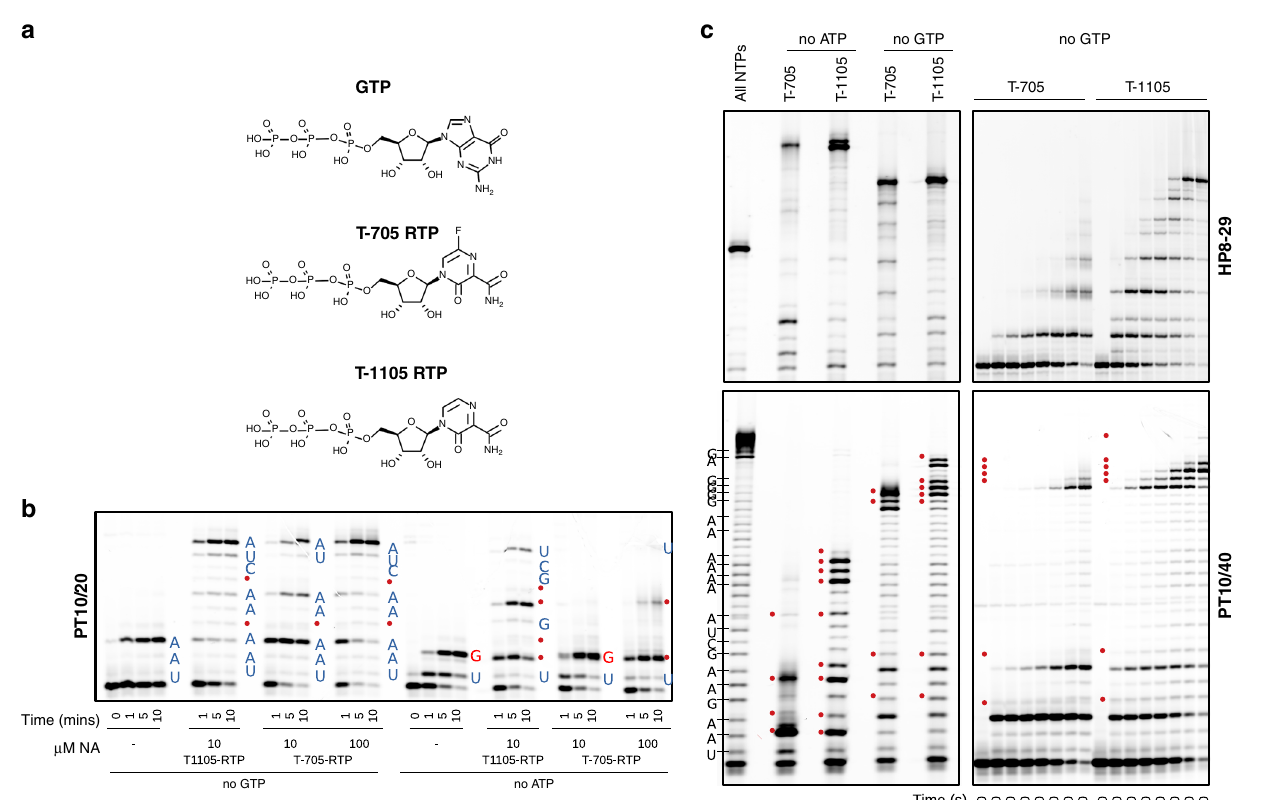
Fig. 3 Incorporation of nucleoside analogues T-705 and T-1105. a Structures of GTP, T-705 and T-1105 in their ribonucleotide triphosphate forms. b Elongation of the PT10/20 substrate in the presence of various analogue concentrations and the absence of ATP or GTP. Red dots show analogue incorporation sites at the omitted nucleotide positions, incorporation of correct nucleotides are indicated by blue letters and GTP:U mismatches by red letters. c Left panel shows products obtained with 100 µ M of each analogue after 5 min. Right panel shows time-course in the presence of 10 µ M of each analogue and absence of GTP. Site assignments for the hairpin substrate are not shown due to drastic differences in RNA migration attributed to changes in residual RNA structure following analogue incorporation. Full time-course series at multiple analogue concentrations are shown in Supplementary Fig. 5b. Source data are provided as a Source Data fi